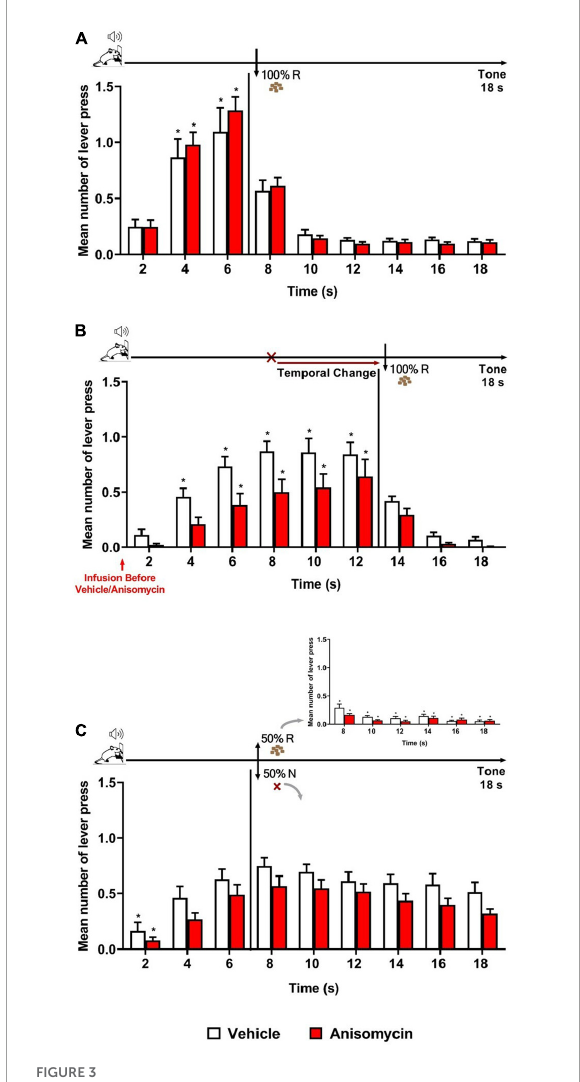
FIGURE3 Anisomycin infusion before the Error session affected responding when a temporal prediction error was detected. Responses average (+SEM) during the 18 s tone, per 2 s, for Vehicle (White columns; n = 15) and Anisomycin (Red columns; n = 16) groups. (A) Retraining session during FI 6 s LH 12 s signaled schedule (* p < 0.05, intra-group differences from 2 s). (B) Error session of Temporal Change during FI 12 s LH 6 s signaled schedule during which the time was changed from 6 to 12 s to obtain the reward, and the vehicle or anisomycin were infused in the BLA 10 min before the session (* p < 0.05, intra-group differences from 2 s). (C) Reinforcement omission effect (ROE) Test session under FI 6 s LH 12 s signaled schedule during which the reward was omitted in 50% of trials (* p < 0.05, intra-group differences from 6 s). FI, fixed-interval; LH, limited hold; R, Reinforcement; N,